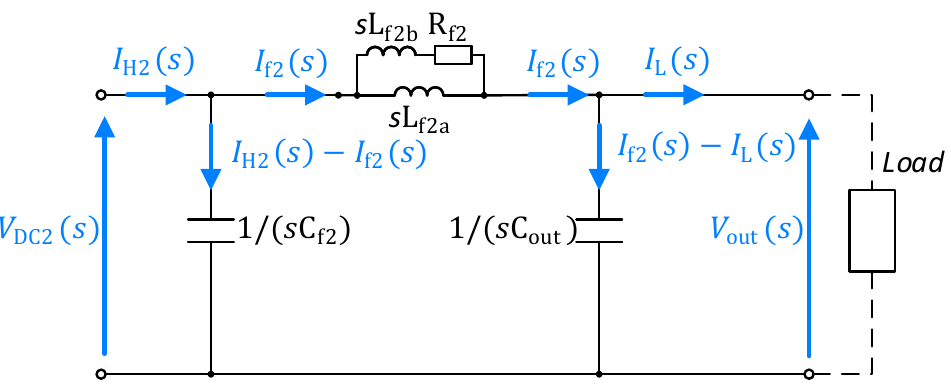
Figure 9. Outer circuit